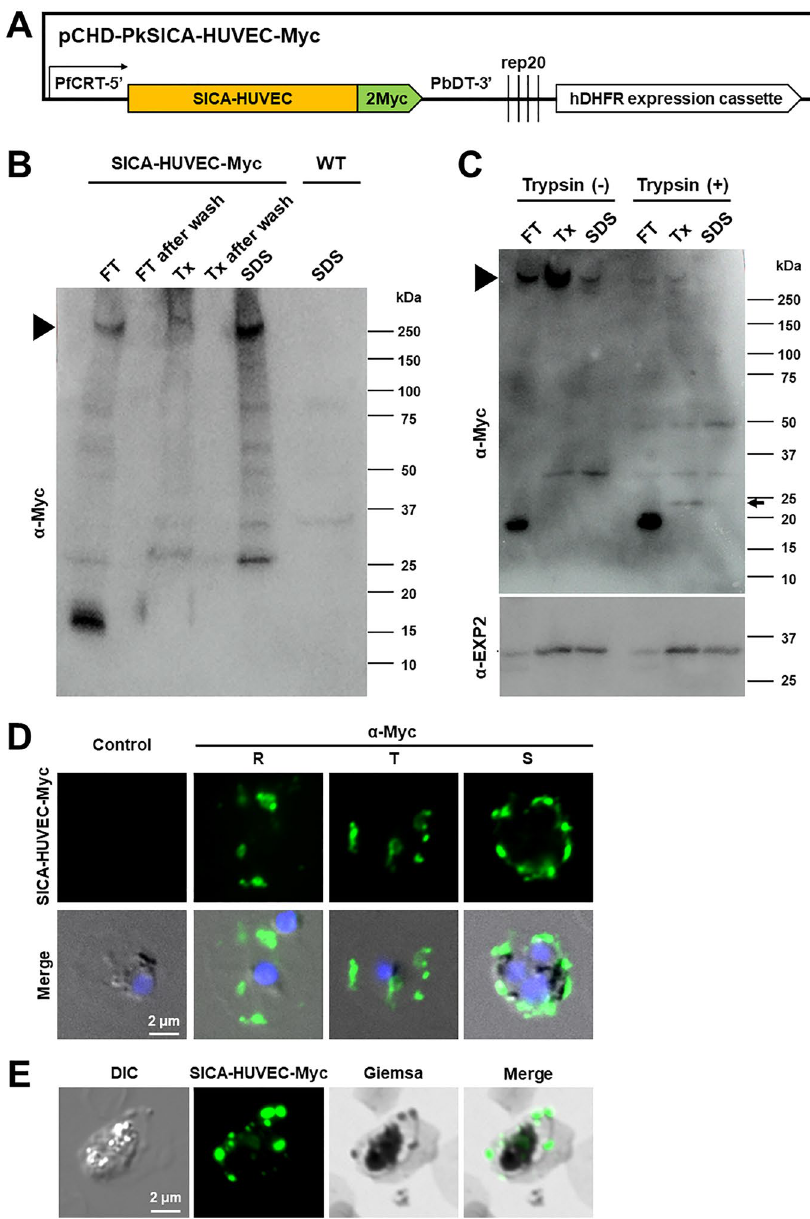
Figure 3. Generation of a transgenic P. knowlesi line expressing SICA-HUVEC-Myc using monkey RBCs. ( A ) A schematic image of the SICA-HUVEC-Myc expression construct. Full-length of SICA-HUVEC was fused with Myc epitopes (Myc) at its C terminus and the P. falciparum CRT promoter region (PfCRT 5 ′ ) was used as a promoter. A human DHFR expression cassette was used for the drug selection. ( B ) Western blotting of the wild- type parental P. knowlesi line (WT) and the transgenic line expressing SICA-HUVEC-Myc in monkey RBCs. Proteins were sequentially extracted by freeze-thawing (FT), with 1% Triton X-100 (Tx), and then with 2% SDS for the transfectants; whereas they were extracted with 2% SDS only for the wild type parasites. Bands detected with anti-Myc antibody (α-Myc) around the expected size for the SICA-HUVEC-Myc are indicated with an arrowhead. ( C ) Trypsin treatment of the transgenic line expressing SICA-HUVEC-Myc. Trypsin-treated or untreated samples were sequentially extracted as described above and subjected to Western blot with α-Myc or a loading control anti-EXP2 antibody (α-EXP2; The original blot is presented in Fig. S10). To make the 24-kDa band (arrow) easier to see, the intensity of the upper image is increased. ( D ) IFA images of P. knowlesi expressing SICA-HUVEC-Myc in monkey RBCs stained with anti-Myc antibody (α-Myc, green). Signals detected with α-Myc were merged with DAPI nucleus signals (blue) and differential interference contrast (DIC) images (Merge). The bottom panels are images from a negative control reacted with normal mouse IgG. ( E ) Images of P. knowlesi expressing SICA-HUVEC-Myc in monkey RBCs stained with Giemsa’s solution following IFA with α-Myc antibody. Signals detected with α-Myc were merged with Giemsa-stained images